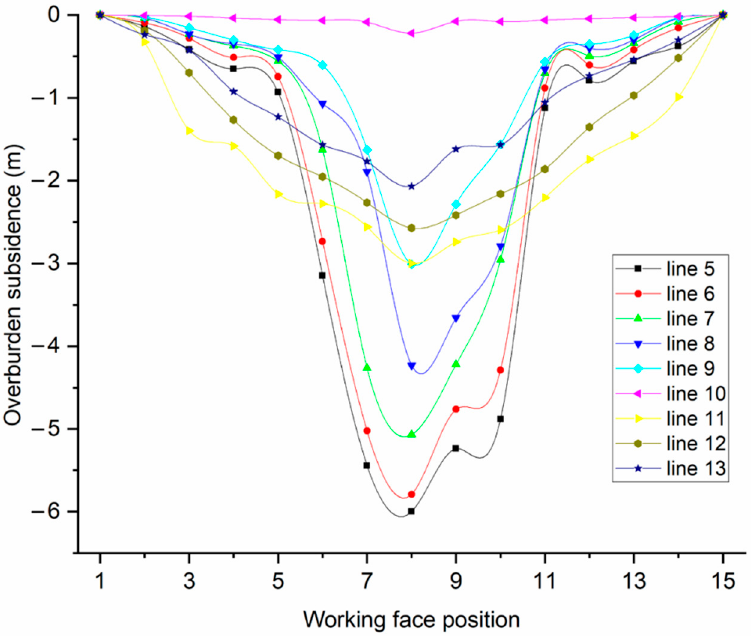
Figure 5. Curve of overburden subsidence of material simulation.